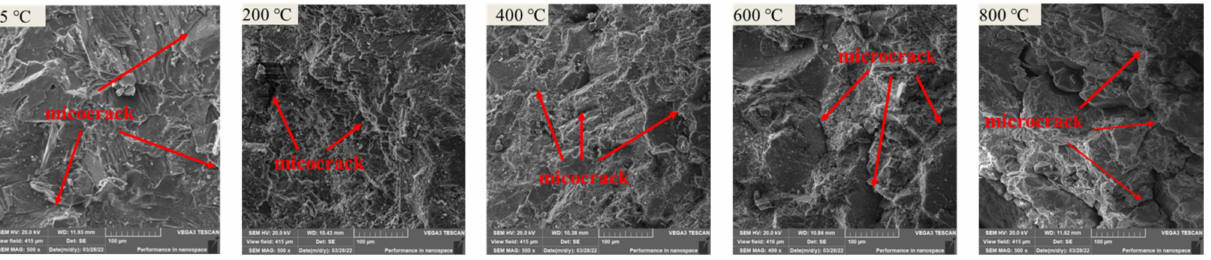
Figure 7. SEM micrograph of marble after high-temperature